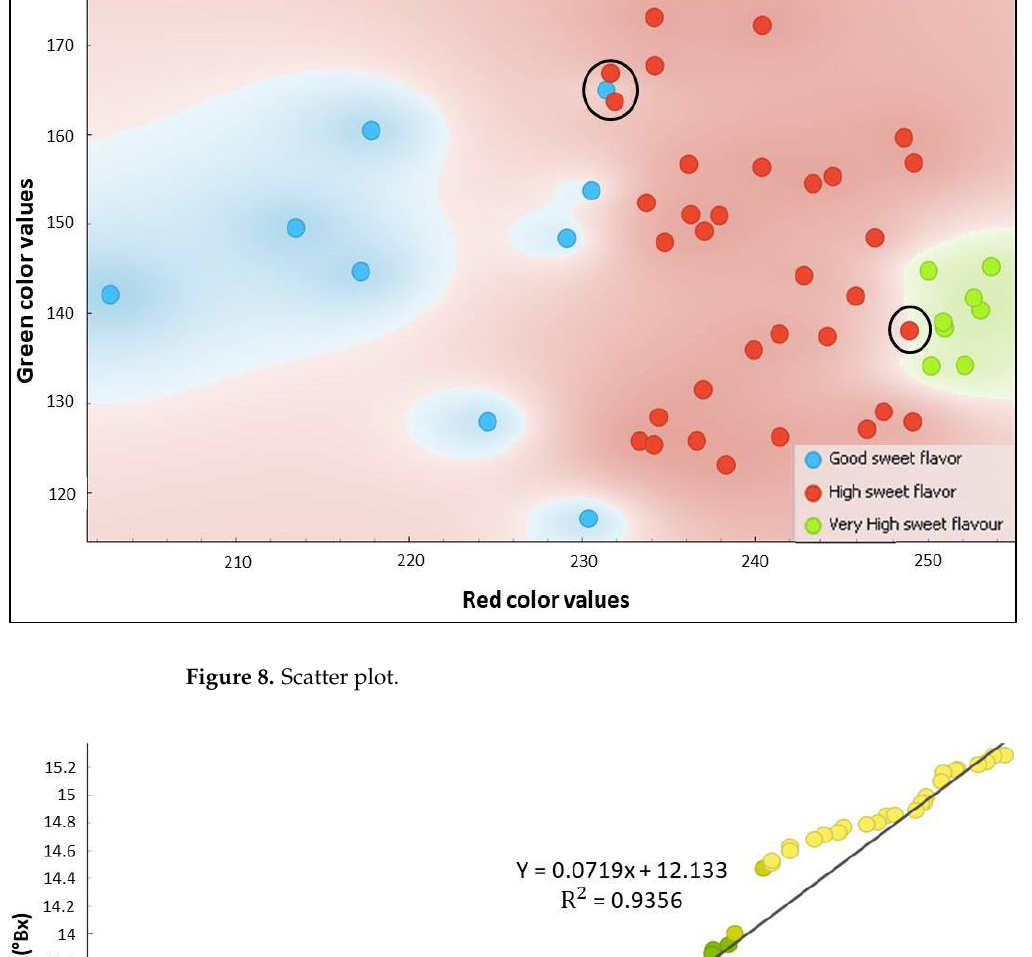
Figure 8. Scatter plot.